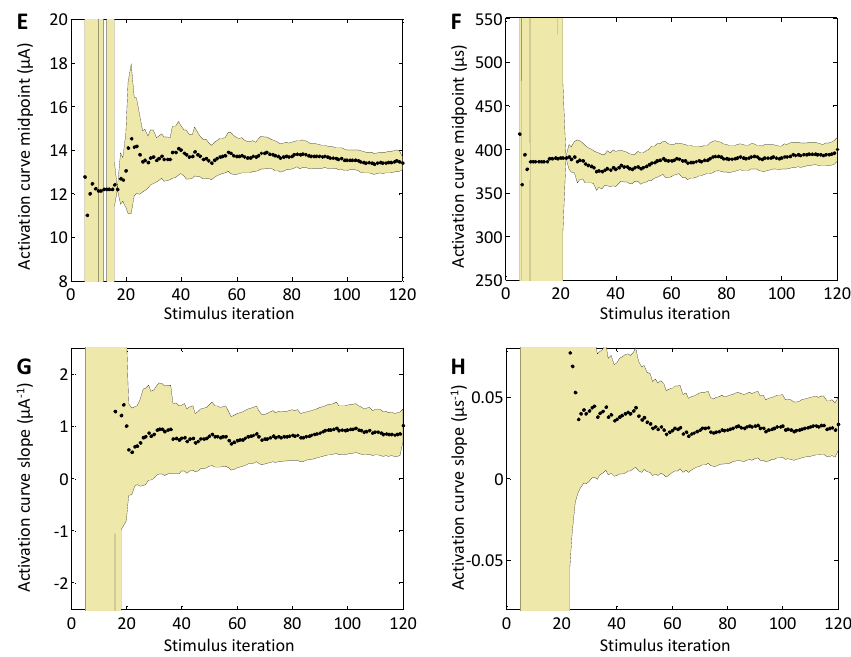
Figure 7. Convergence of the closed-loop algorithm on the sigmoid model parameters. During an experiment, one stimulus parameter (current or pulse width) is fixed while the other is allowed to vary according to the closed-loop algorithm in order to find the neuronal activation curve. In one set of CL stimuli the pulse width was fixed at 1000 µ s and the current was varied ( A , C , E , G ), and in another set of stimuli the current was fixed at 30 µ A and the pulse width was varied ( B , D , F , H ); ( A , B ) The best-fit sigmoid from Equation (1) is plotted after the final stimulus iteration for each of the stimulus current and pulse-width searches. The activation curve is defined for probabilities spanning from zero to one. The averaged response to each of the stimulus values is depicted with open circles, which are proportional in size to the number of stimuli that were delivered at that value. The 10% to 90% probability regions span 4.3 µ A and 130 µ s. ( C , D ) The individual measured response to each stimulus is plotted as a dot to denote that an action potential was detected or an “X” to denote that no action potential was detected. The stimuli span the range of probabilities from the sigmoid activation curve. Two points were excluded in both plots from the extremes of the stimulus range, for clarity at the region of interest. The excluded stimuli at maximum intensity produced an action potential, and those at minimum intensity did not. ( E – H ) The convergence of the sigmoid midpoint and slope is shown with stimulus iteration. The black circles record the best fit of each of the two sigmoid parameters, midpoint and slope, from the nonlinear least squares curve fit of Equation (1), after each stimulus iteration. The shaded region marks the 95% confidence interval on the fit